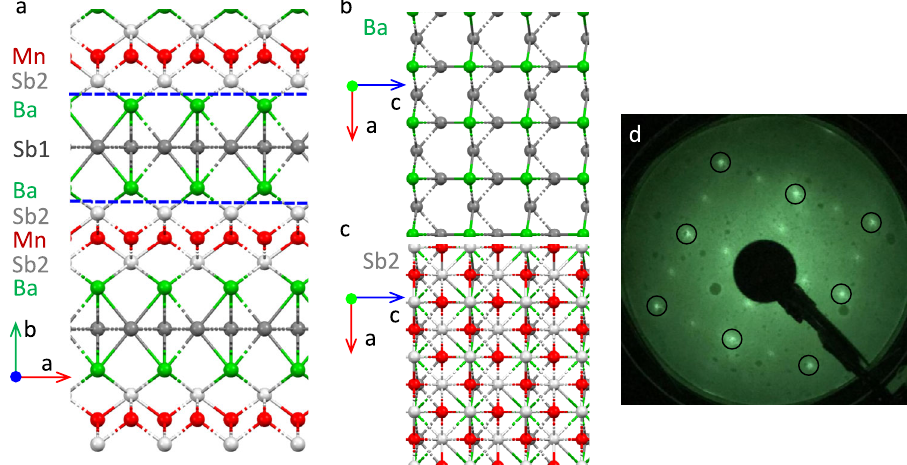
Fig. 1 Crystal structure of BaMnSb 2 . a Schematic ball and stick model showing the crystal structure of BaMnSb 2 with the Imm 2 space group. Ba, Sb1, Sb2 and Mn layers are indicated. b , c Schematic drawing of the two cleavage terminations Ba and Sb2 which correspond to the blue dotted layers in ( a ), respectively. d LEED pattern from a surface showing 2 × 1 reconstruction with domains, collected at 77 K with the energy of 60 eV. The integer spots are marked with black